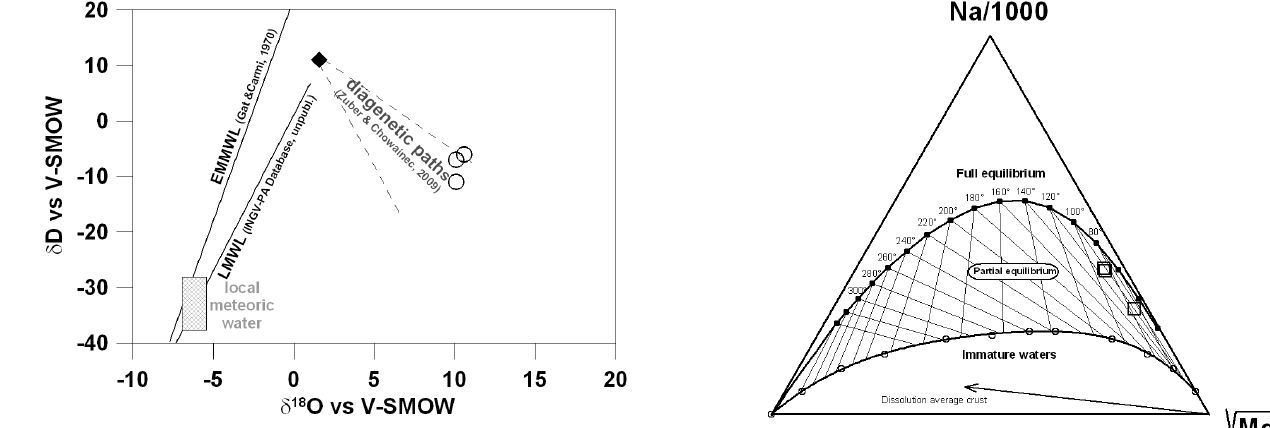
Fig. 10. Ternary Na-K-Mg diagram (after Giggenbach, 1988). Col- lected waters fall with the “partial equilibrium” field at temperatures between 80 and 130 ◦ C (concentrations in mgl ◦